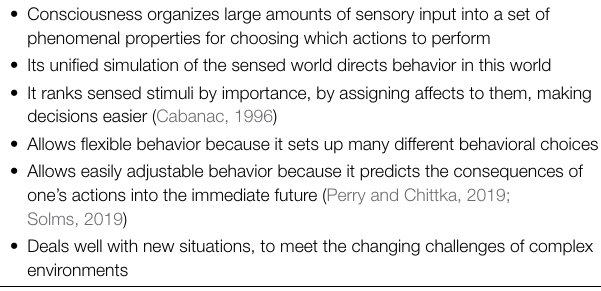
TABLE 2 | Some adaptive roles of consciousness (from Feinberg and Mallatt, 2019) that constrain the types of features that can produce this